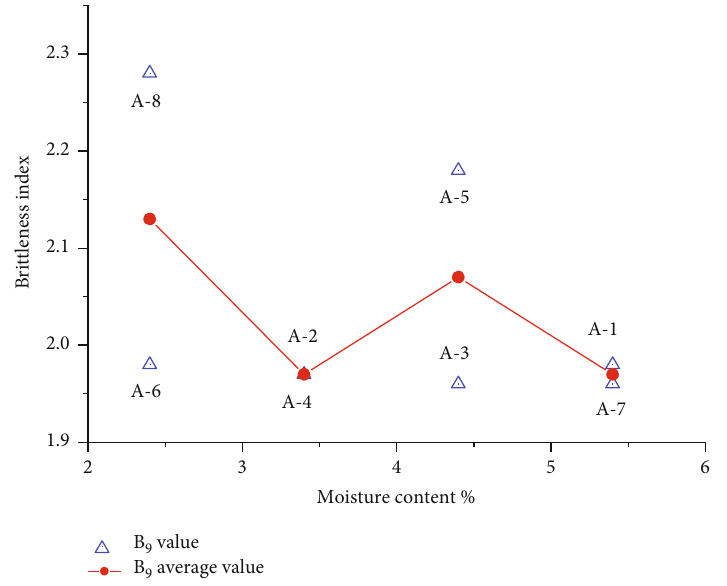
Figure 7: B under di ff erent water 9